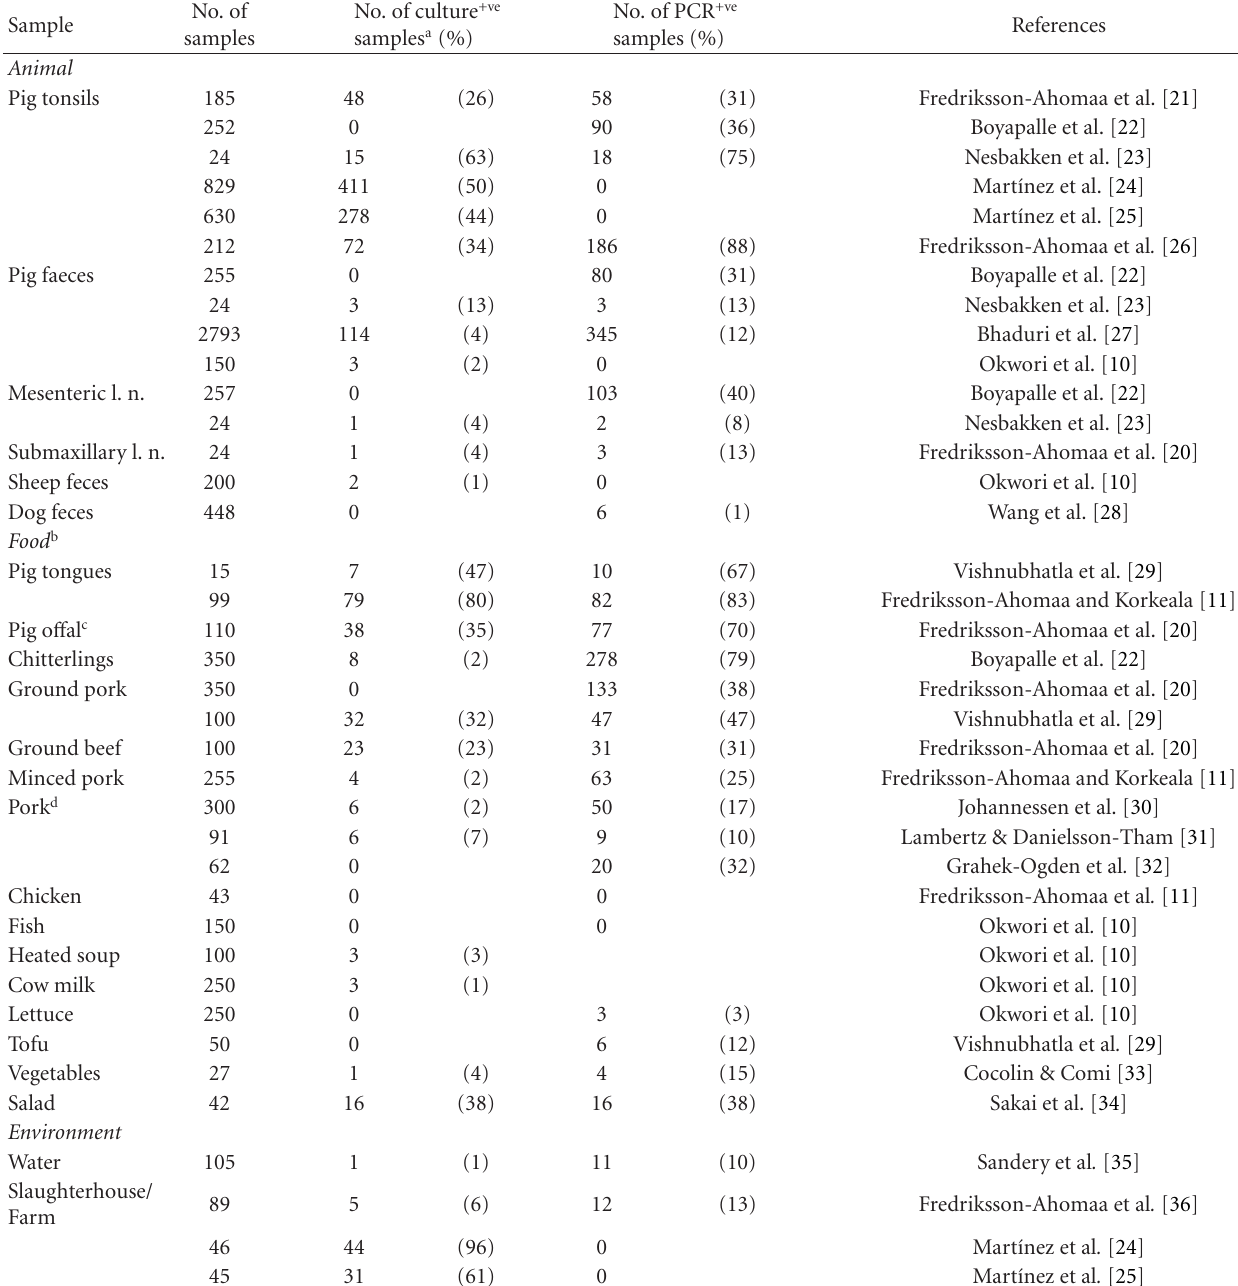
Table 1: Detection of pathogenic Y. enterocolitica in natural samples with PCR and culture methods.